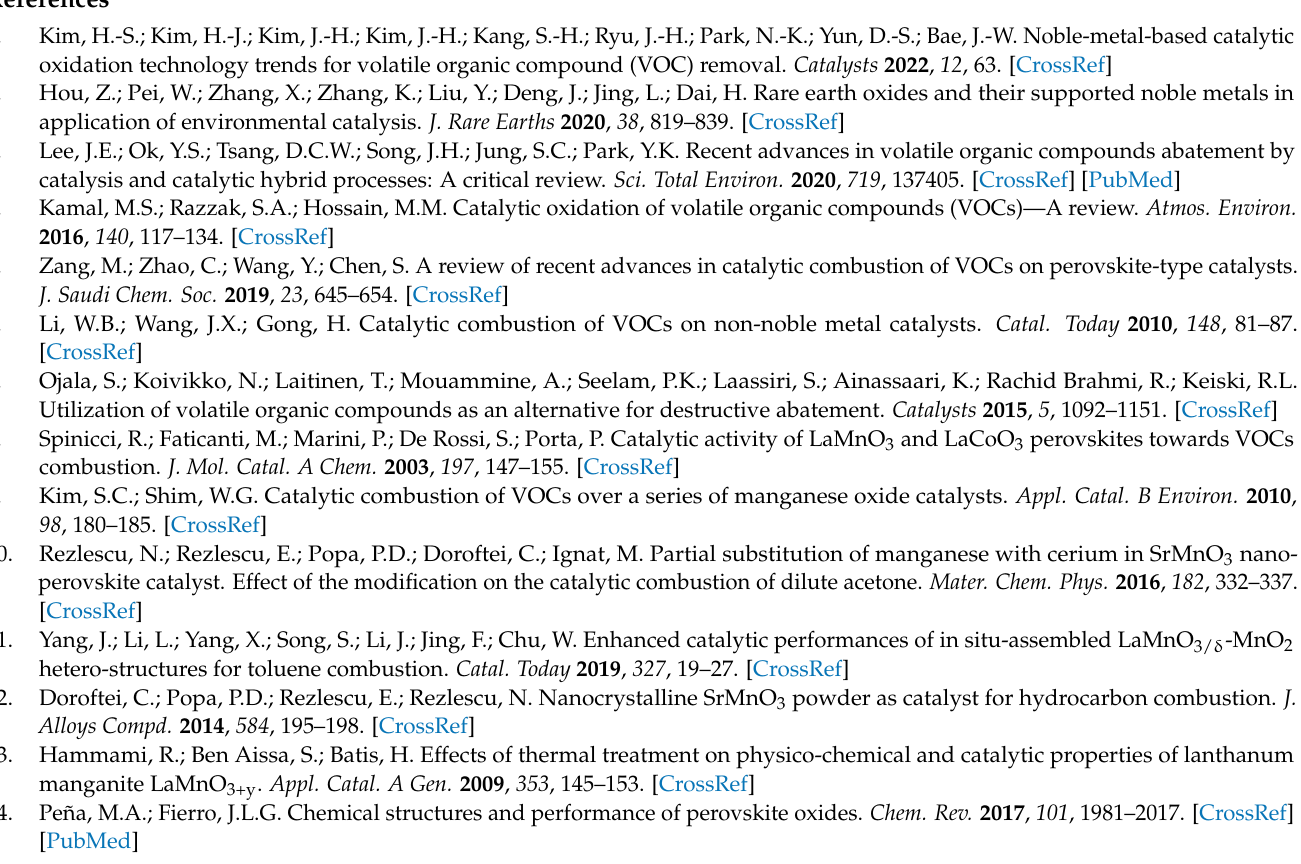
Final parameters for the as-prepared samples XRD data obtained through Rietveld fit. Table S3: